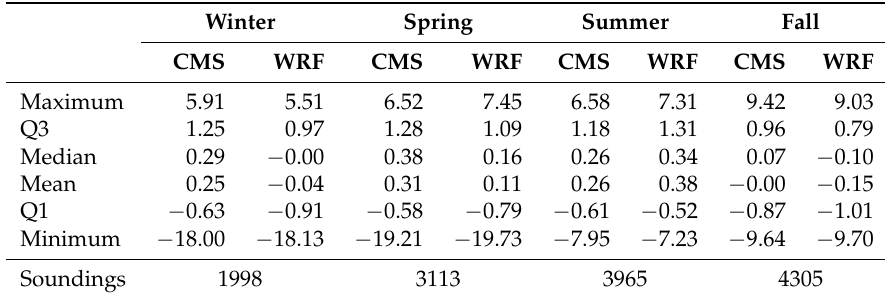
Table 4. Model residuals [ppm] relative to ACOSv3.5 GOSAT XCO 2 . The span between the distribution quantiles Q3 and Q1 defines the interquartile range (IQR). IQRs for residuals of both models and all seasons are in the range [1.8, 1.9]